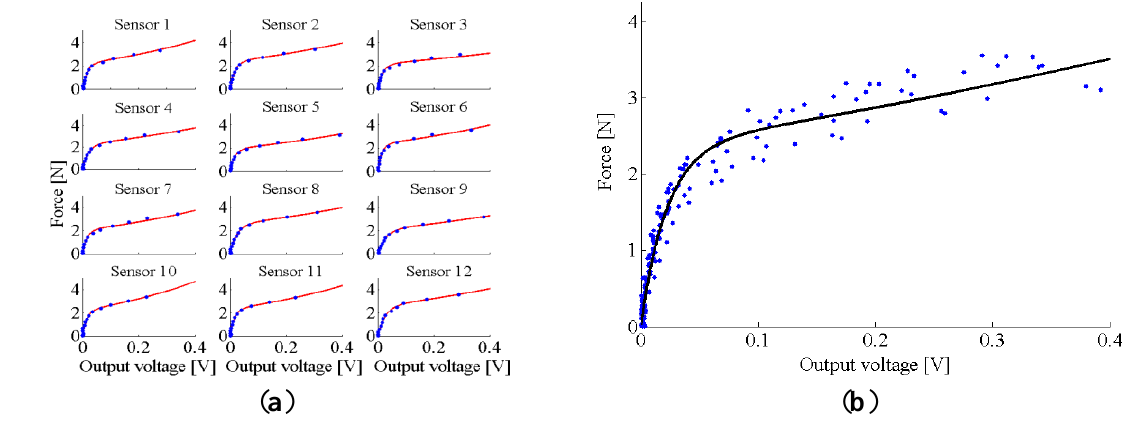
Figure 7. Force-to-output voltage characterization of the sensitive element: ( a ) experimental data (blue dots) and fitting model (solid red line) of the 12 selected sensors; ( b ) experimental data of the 12 selected sensors (blue dots) and averaged fitting model (solid black line).